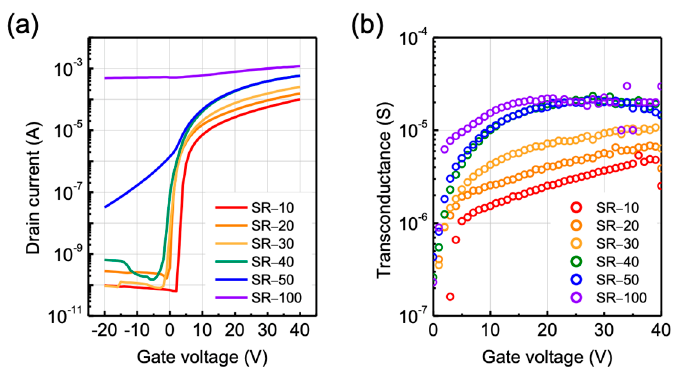
Figure 3. ( a ) Transfer characteristics and ( b ) transconductance of ZTO TFTs with various annealing times.